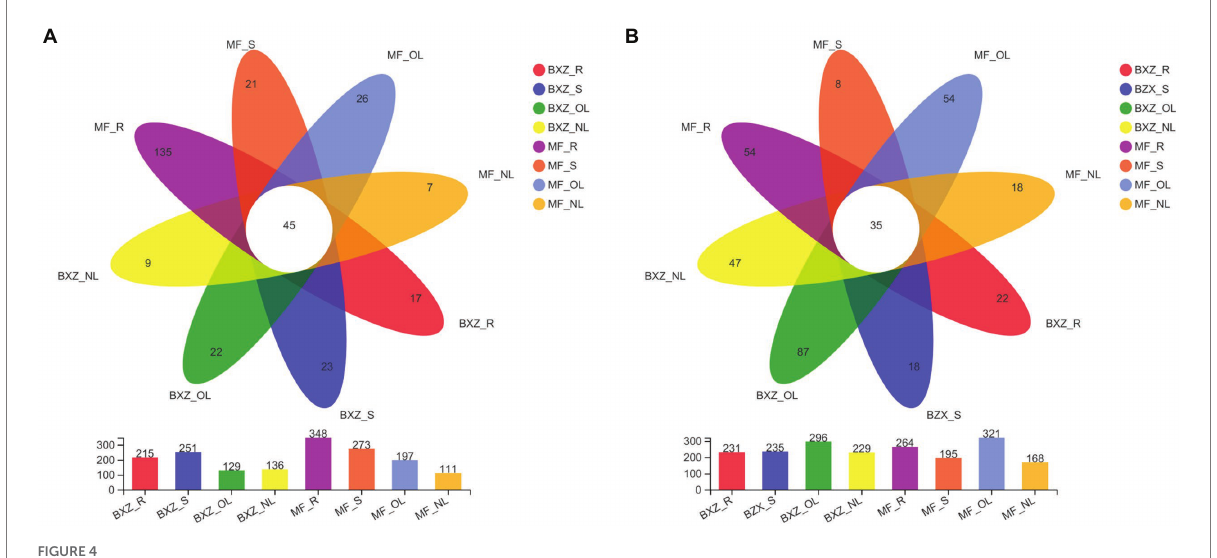
FIGURE 4 Common, tissue/cultivar-specific bacterial (A) and fungal (B) OTUs in tea tree. BXZ_R, BXZ_S, BXZ_OL and BXZ_NL represented root, stem, old leave and new leave samples of BXZ cultivar., while MF_R, MF_S, MF_OL and MF_NL represented root, stem, old leave and new leave samples for MF